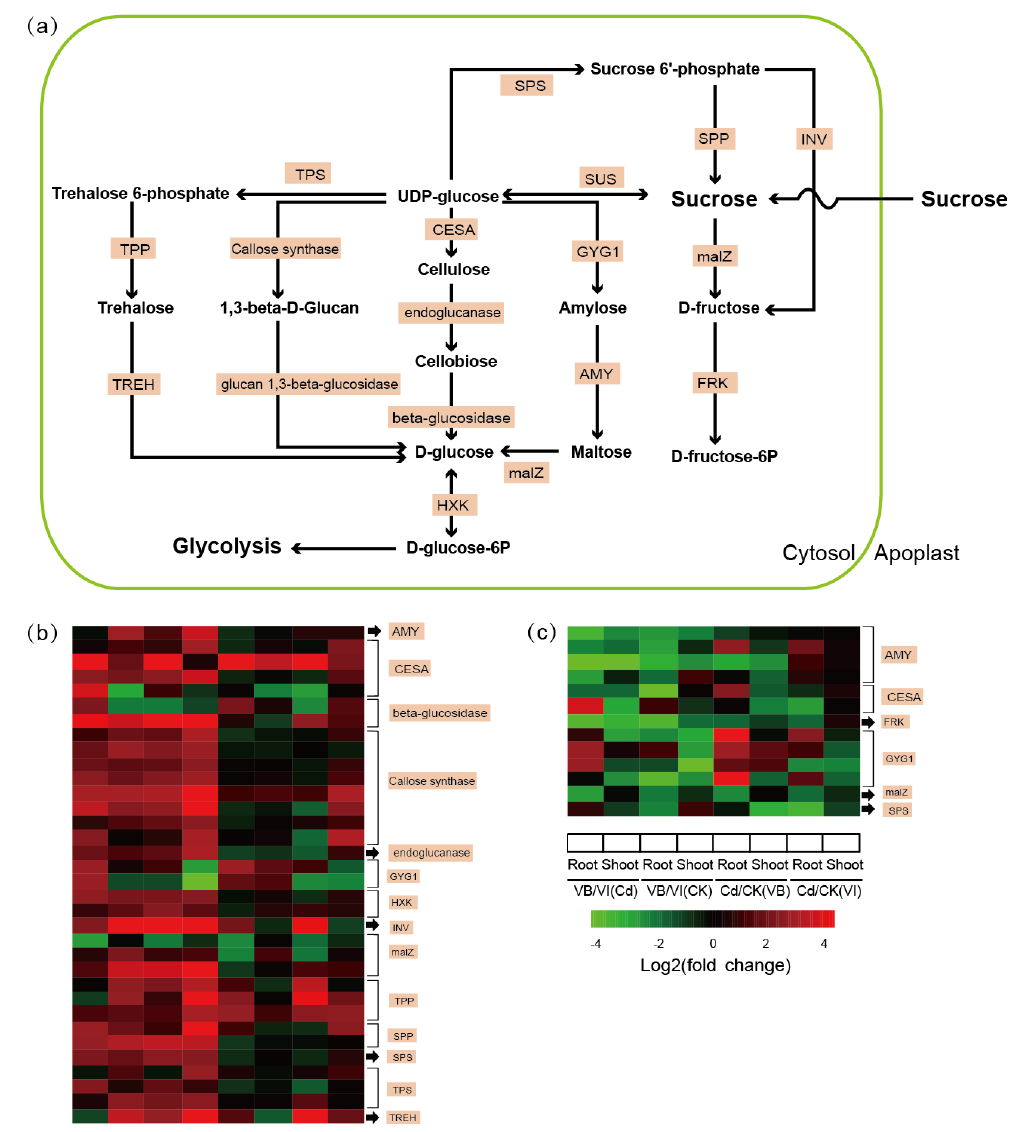
Figure 5. DEGs involved in sucrose metabolism with differential transcription levels in the two Viola species. ( a ) Schematic diagram of the sucrose metabolism pathway in Viola . ( b ) Heat maps of genes involved in sucrose metabolism with constitutively higher transcription levels in Viola baoshanensis . ( c ) Heat maps of genes with constitutively higher transcription levels in V. inconspicua . AMY, alpha-amylase; CESA, cellulose synthase; FRK, Fructokinase; HXK, Hexokinase; GYG1, glycogenin; INV, beta-fructofuranosidase; malZ, alpha-glucosidase; SPP, sucrose-6-phosphatase; SPS, sucrose-phosphate synthase; TPP, trehalose 6-phosphate phosphatase; TPS, trehalose 6-phosphate synthase; TREH, alpha trehalase. See more details in Table S12, Sections 2.5 and